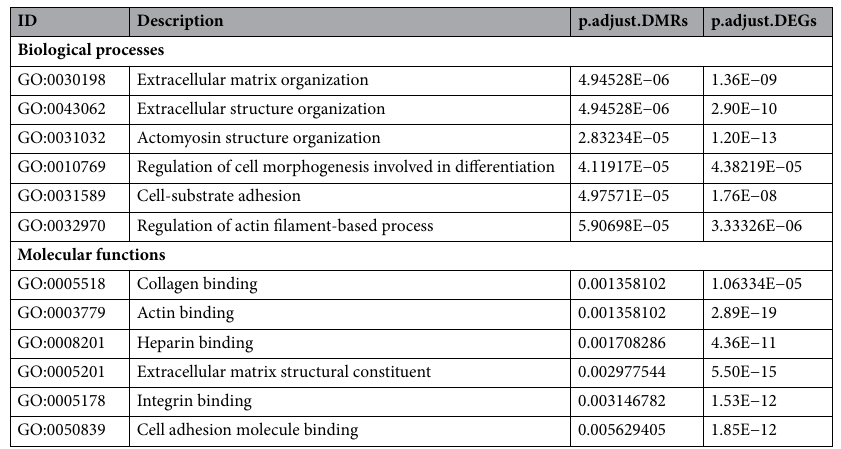
Table 1. Functional integration of differentially expressed genes and differentially methylated regions. Summary of the Gene Ontology (GO) Biological Processes (BP) and Molecular Functions (MF) categories identified using differentially expressed genes (DEGs) and differentially methylated regions (5mC, DMRs). The table includes 6 of the top Biological Processes (out of a total of 58) and all identified Molecular Functions, including the adjusted p values (p.adjust) for DMRs and